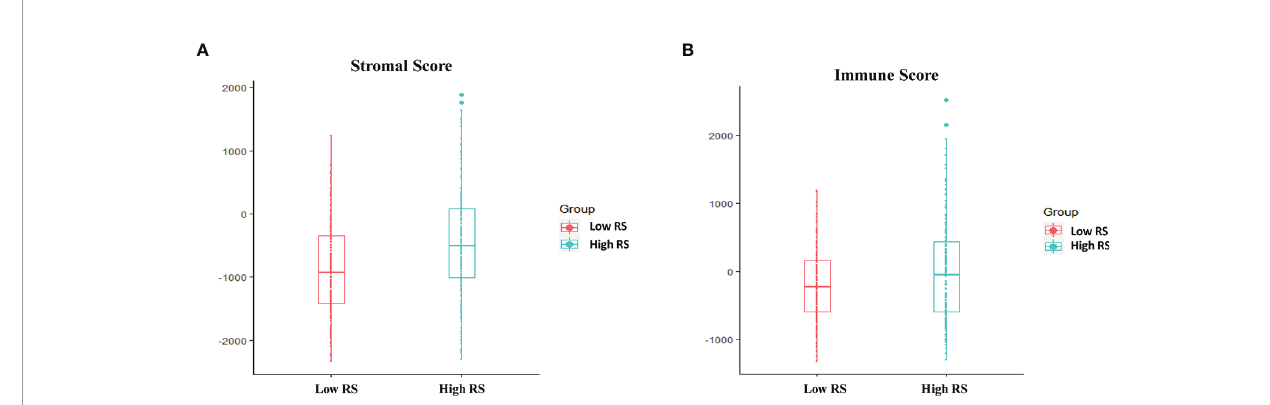
FIGURE 8 | Associations between immune score, stromal score, and risk score. (A) Stromal scores of the high-risk group and the low-risk group in The Cancer Genome Atlas (TCGA) analysis. (B) Immune scores in the high-risk group and the low-risk group in TCGA